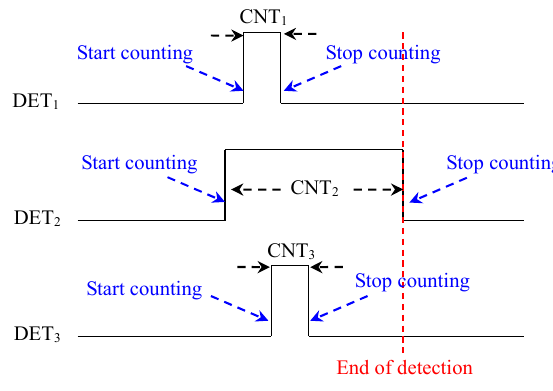
Figure 6. The principle of blowing position detection.